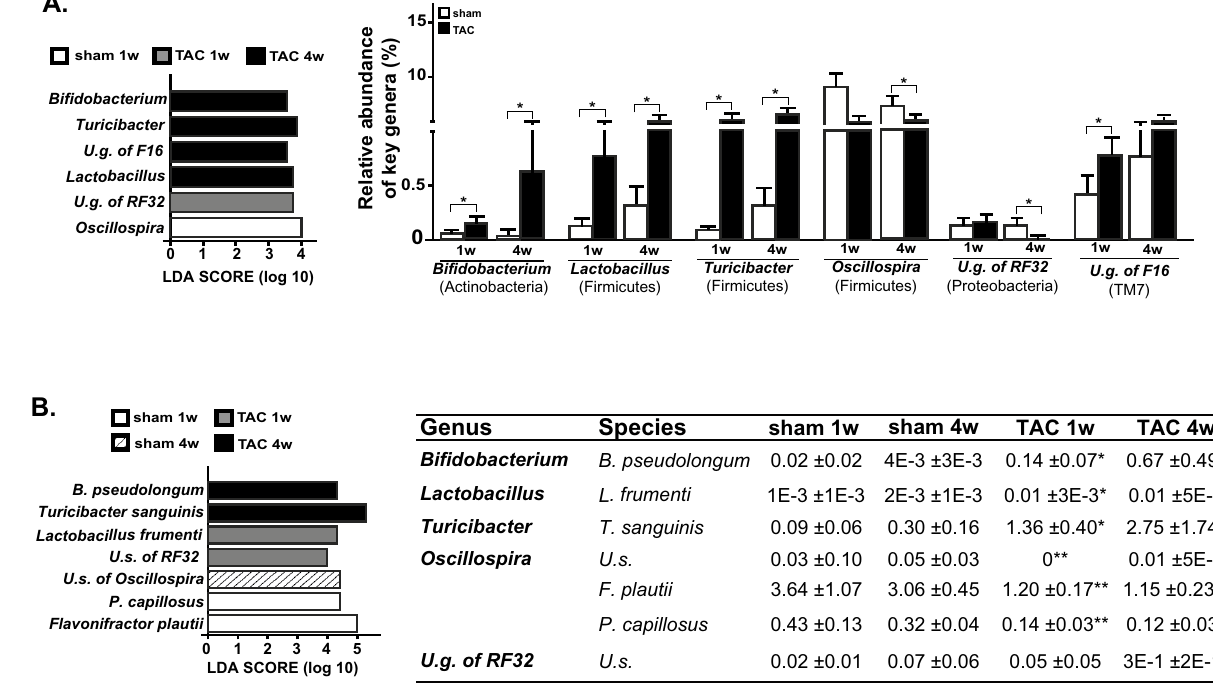
Figure 3. Gut microbiota composition after sham or TAC surgery in mice. Gut microbiota differences based on 16S rDNA sequencing at genus ( A ) and species ( B ) taxonomic levels were identified using linear discriminant analysis (LDA) combined with effect size (LEfSe) algorithm. In each panel, LDA scores (left) and relative abundance (right) of key phylotypes discriminating sham and TAC bacterial communities are reported (sham n = 8; TAC n = 9). Statistical significances were assessed using LEfSe analysis with alpha values of 0.05 for both Kruskal–Wallis and pairwise Wilcoxon tests and a cutoff value of LDA score (log10) above 2.0 (*p < 0.05 and **p < 0.01 vs. correspondent